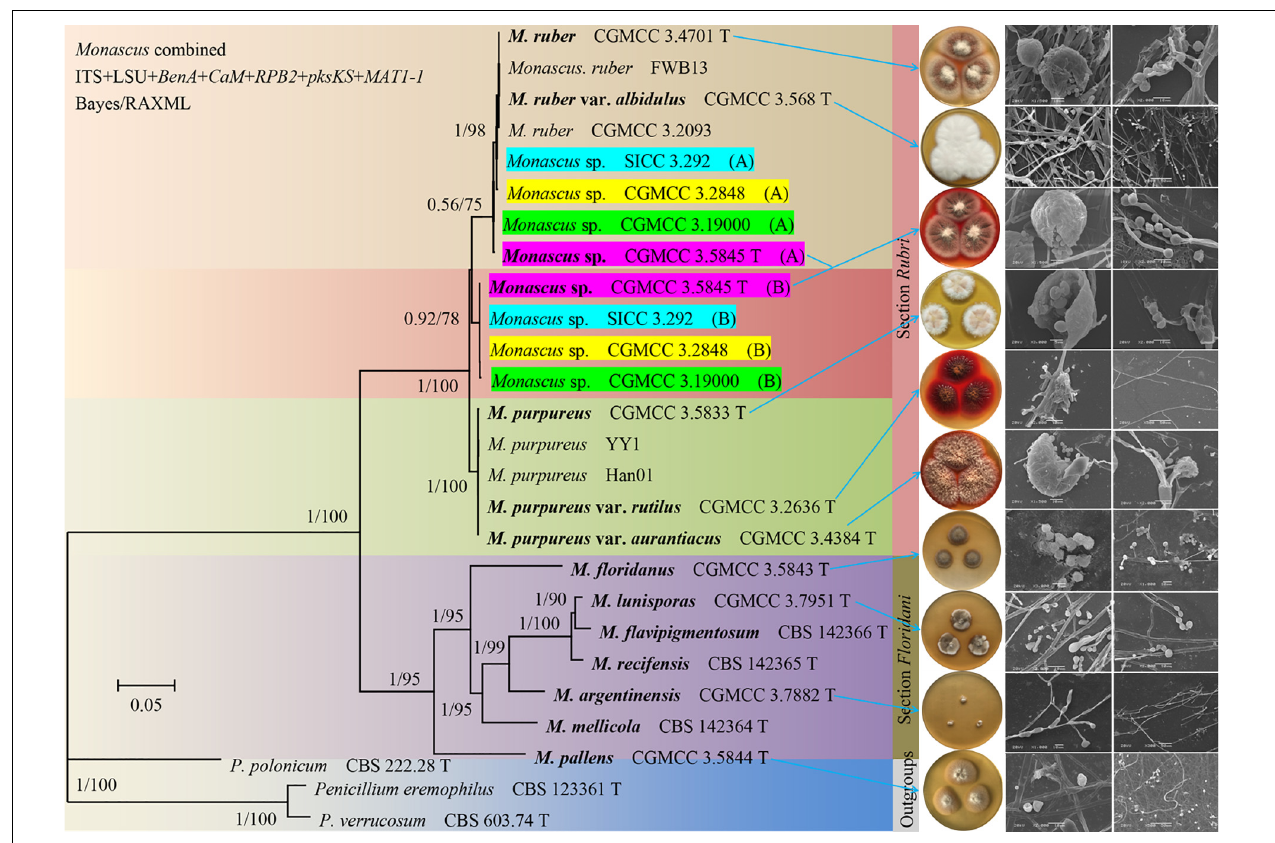
FIGURE 1 | Phylogeny of Monascus . Phylogenetic tree constructed from Bayesian analysis of the concatenated sequences of five protein genes ( BenA , CaM , RPB2 , pksKS , and MAT1-1 ) and two ribosomal RNA genes (ITS and LSU) with a total length of 6,983 bp. Posterior probabilities from Bayesian analysis/bootstrap percentages from 1,000 replicates of maximum likelihood analysis are shown on major branches. The right side of the figure is the cultural characters and scanning electron microscope structural of the strains indicated by the arrow. For the sake of illustration, the M. sp. CGMCC 3. 5845 (A) in the figure are manually